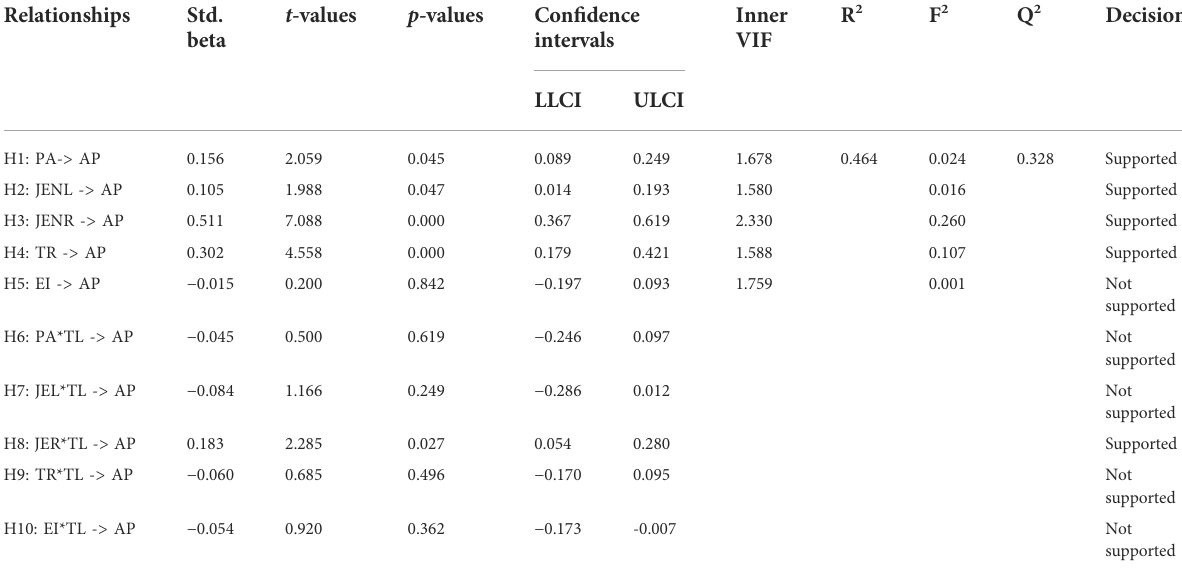
TABLE 3 Proposed hypothesis testing